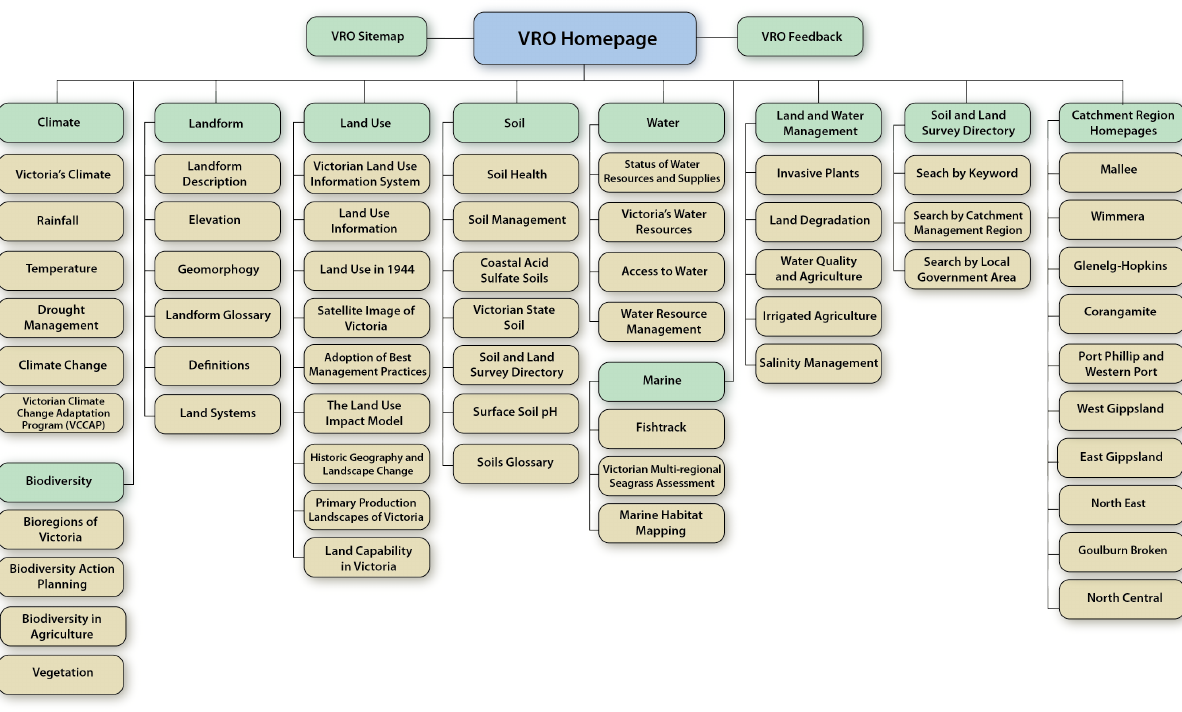
Figure 4. Schematic diagram depicting the primary (homepage), secondary and tertiary level Information Architecture for the VRO statewide